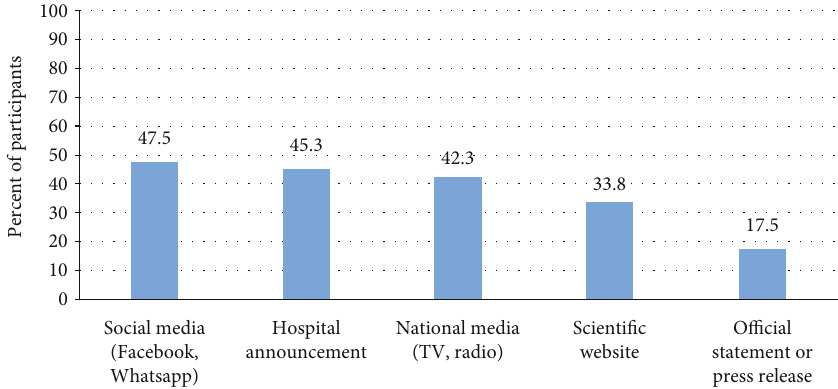
Figure 1: Sources of information about COVID-19 vaccines as reported by participants ( n = 400 ).